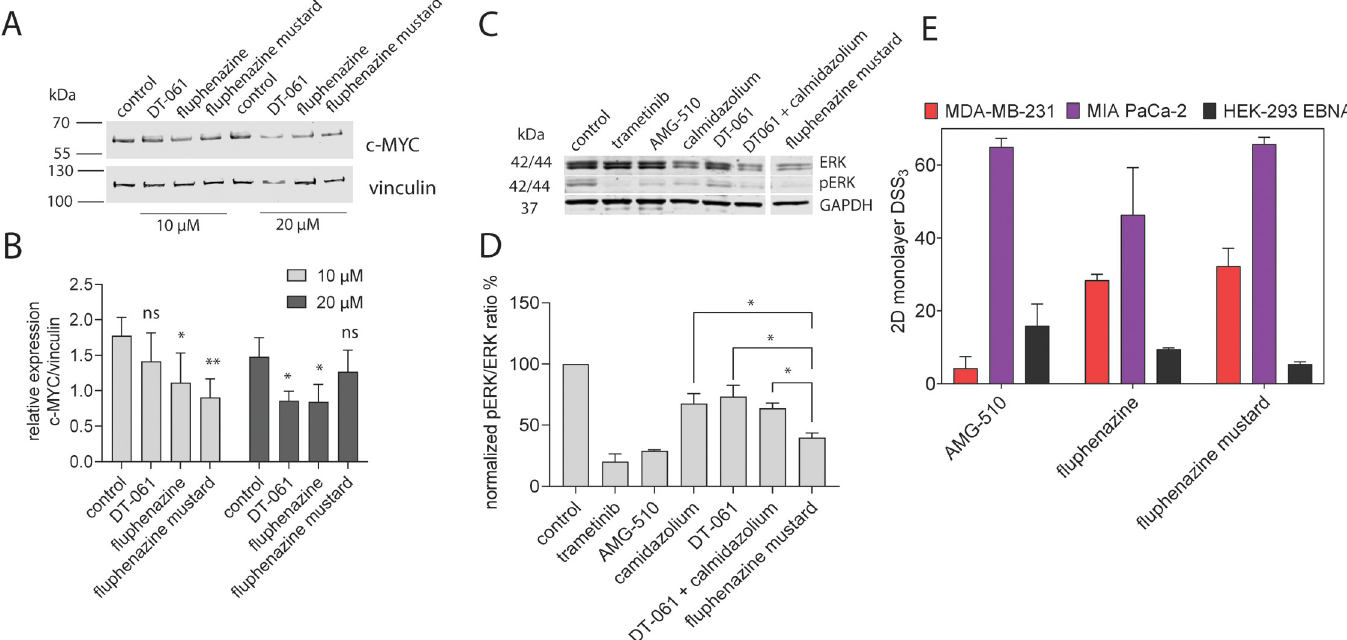
Fig 4. PP2A activity, MAPK signaling and anti-proliferative effects of Flu-M. (A) Expression levels of c-MYC was measured in MDA-MB-231 after treatment with 10 μ M or 20 μ M of inhibitors for 24 h. Vinculin was used as loading control. A representative blot from 4 biological repeats is presented. (B) Expression of c-MYC relative to vinculin levels was analyzed. 0.1% (v/v) and 0.2% (v/v) of DMSO was used as control for 10 μ M and 20 μ M compound treatments, respectively. Data represent mean ± SD of 4 biological repeats. Statistical analysis was performed using unpaired t-test. (C) MAPK signaling output was measured in MIA PaCa-2 cells after 2 h treatment of trametinib (1 μ M), AMG-510 (1 μ M), calmidazolium (20 μ M), DT-061 (20 μ M), combination of DT-061 and calmidazolium (each 10 μ M) and fluphenazine mustard (20 μ M) in the absence of serum followed by EGF stimulation (50 ng/ml) for 10 min. 0.2% (v/v) DMSO was used as vehicle control. Representative blot from three independent biological repeats. (D) Densitometric quantification of the pERK/ERK ratio of all three biological repeats (mean values ± SD) normalized to control. Statistical analysis was performed using unpaired t-test. (E) DSS 3 measuring the anti-proliferative effects of AMG-510 (0.003–40 μ M), fluphenazine (0.6–80 μ M) and fluphenazine mustard (0.6–80 μ M). Results represent mean values ± SD, n = 3.